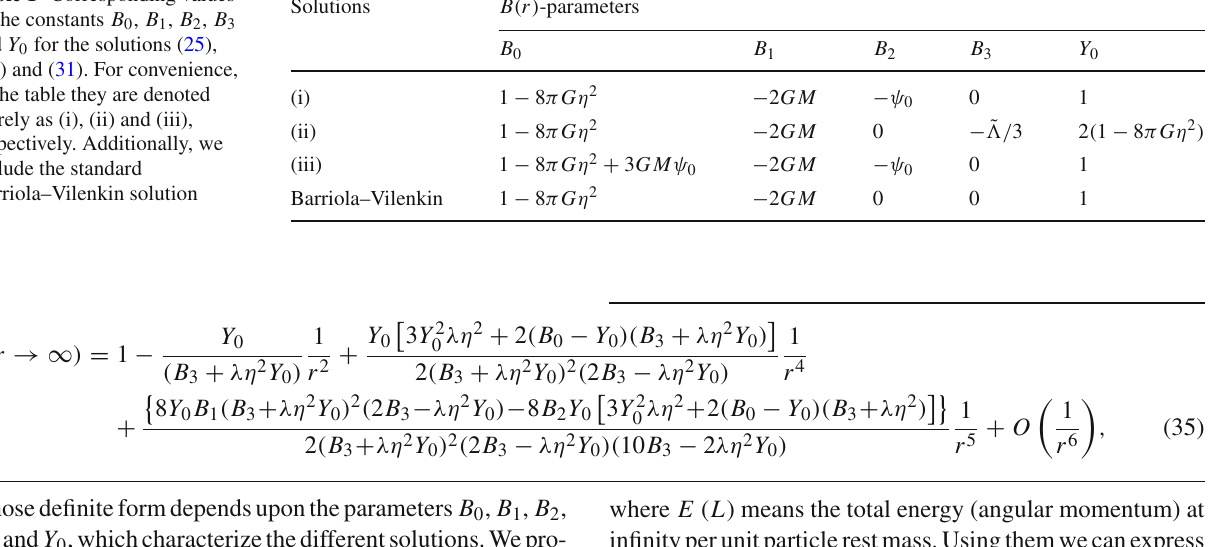
Table 1 Corresponding